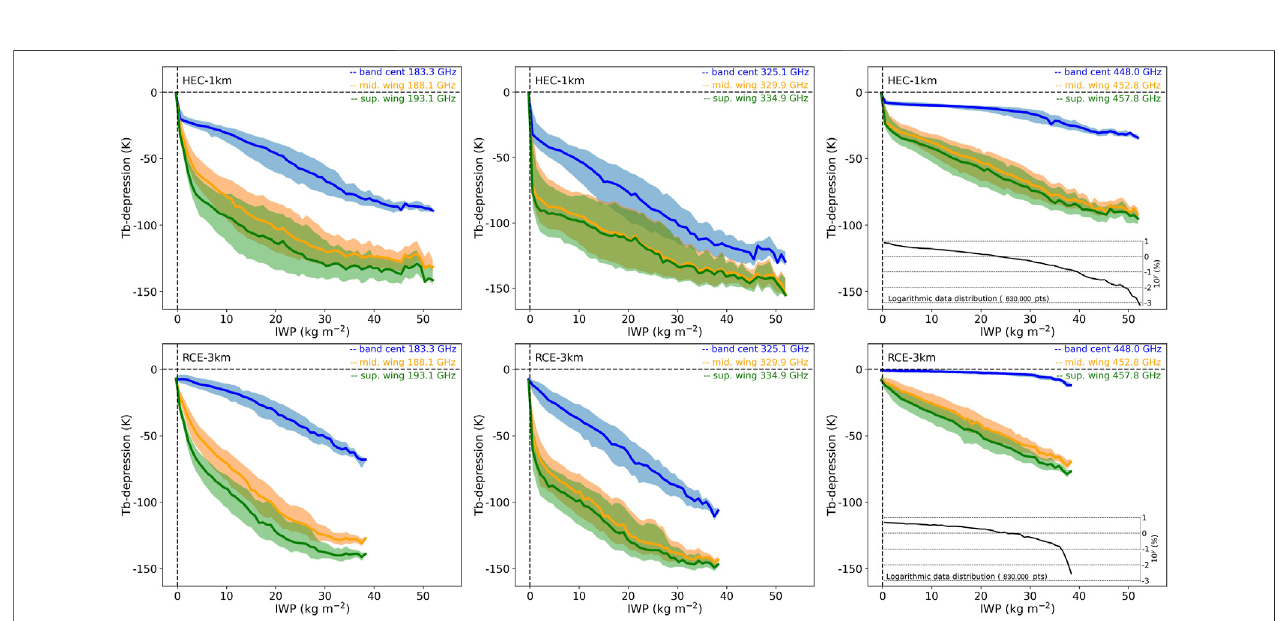
FIGURE 1 | Pro fi les of (from left to right) temperature, water vapor, cloud water, rain, cloud ice, snow, and graupel mixing ratios. The median (bold lines) and the 10 – 90 percentile ranges (shadings) are shown for HEC (green) and RCE (blue).